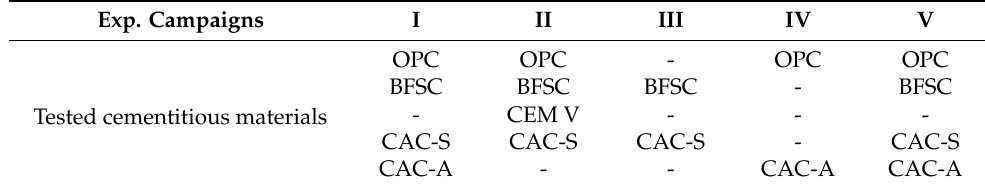
Table 3. The experimental campaigns and the cementitious materials tested in each campaign. Exp. Campaigns